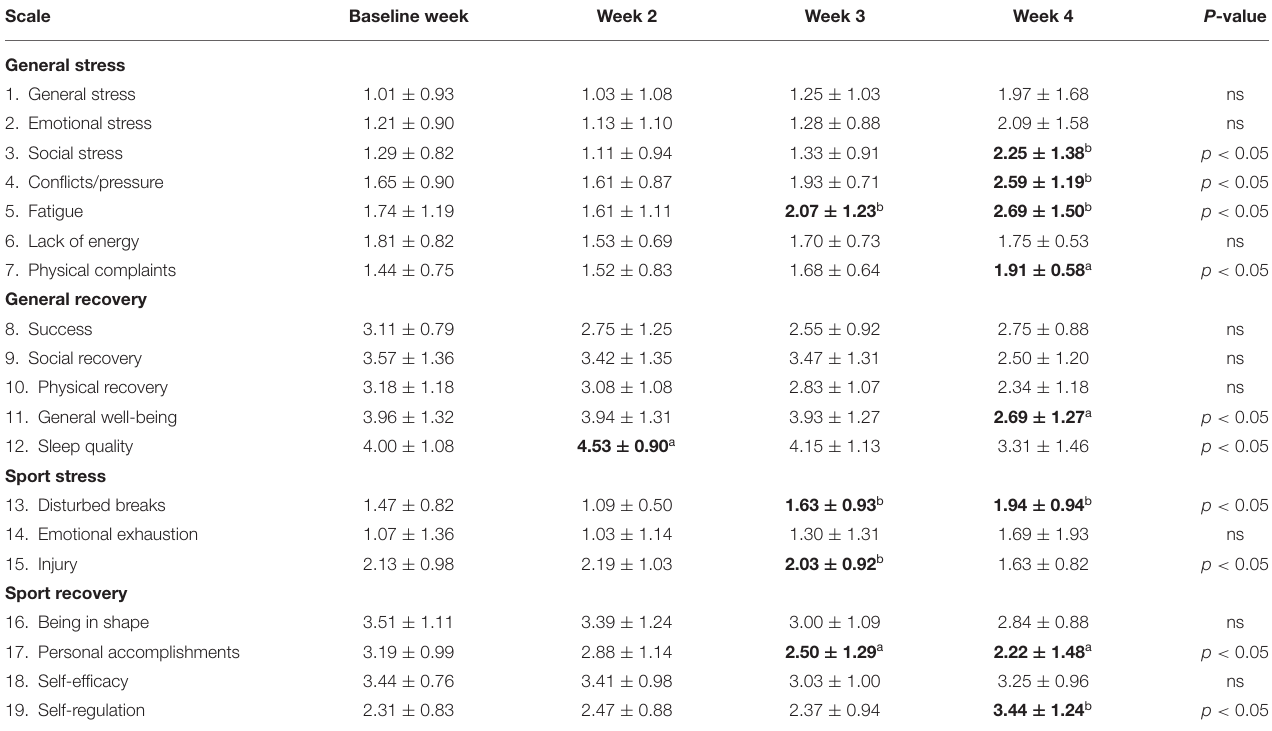
TABLE 1 | Average scores (mean ± SD) of the Recovery-Stress Questionnaire for Athletes (RESTQ-Sport) scales during the 4-week training period.